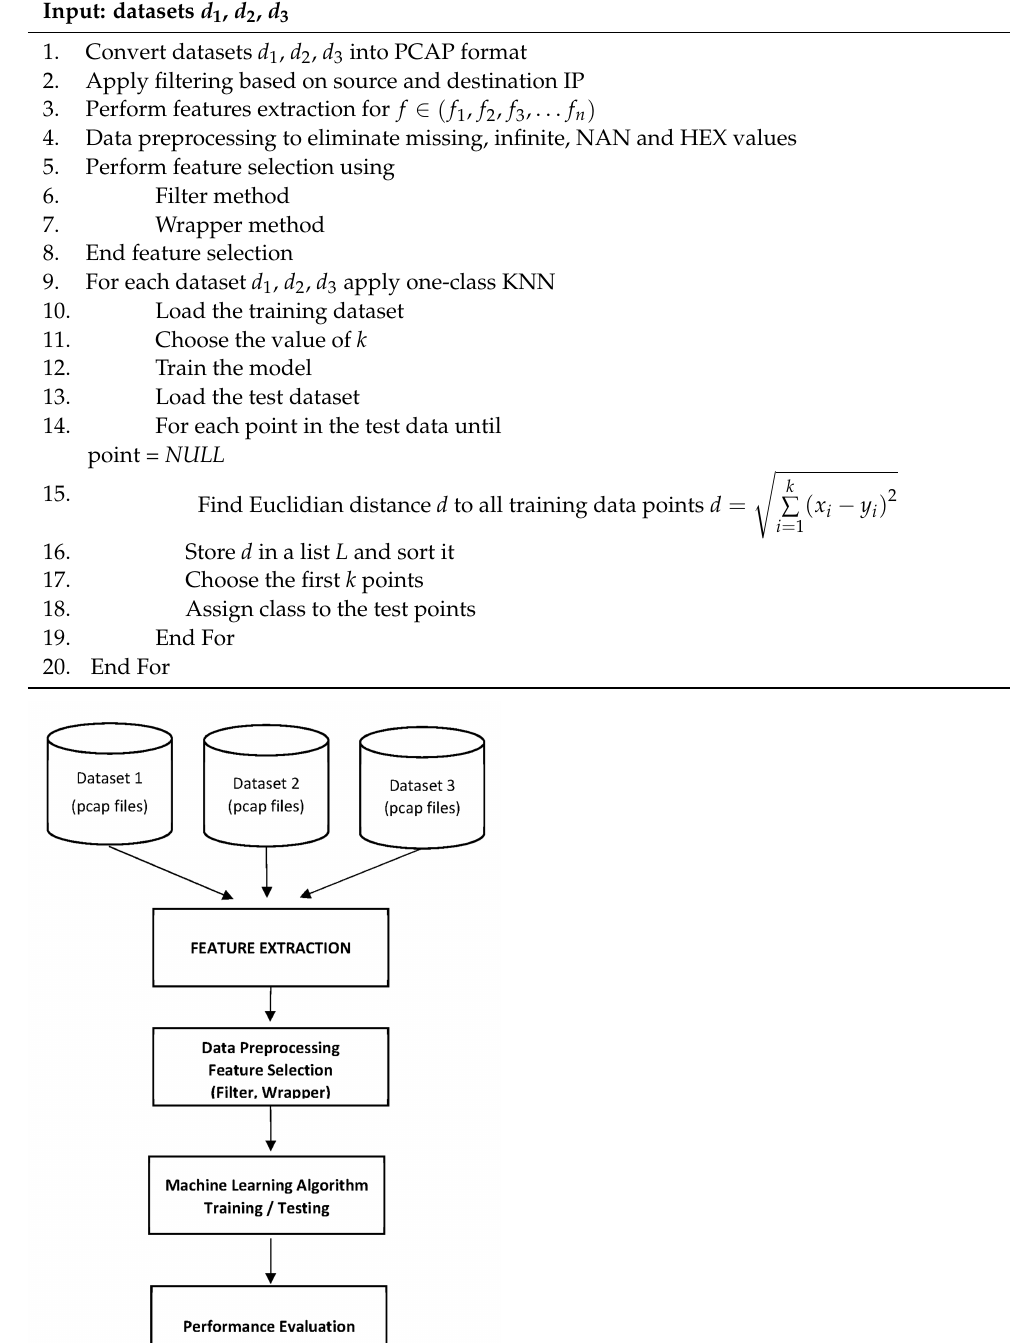
Algorithm 1: Botnet detection using one-class KNN